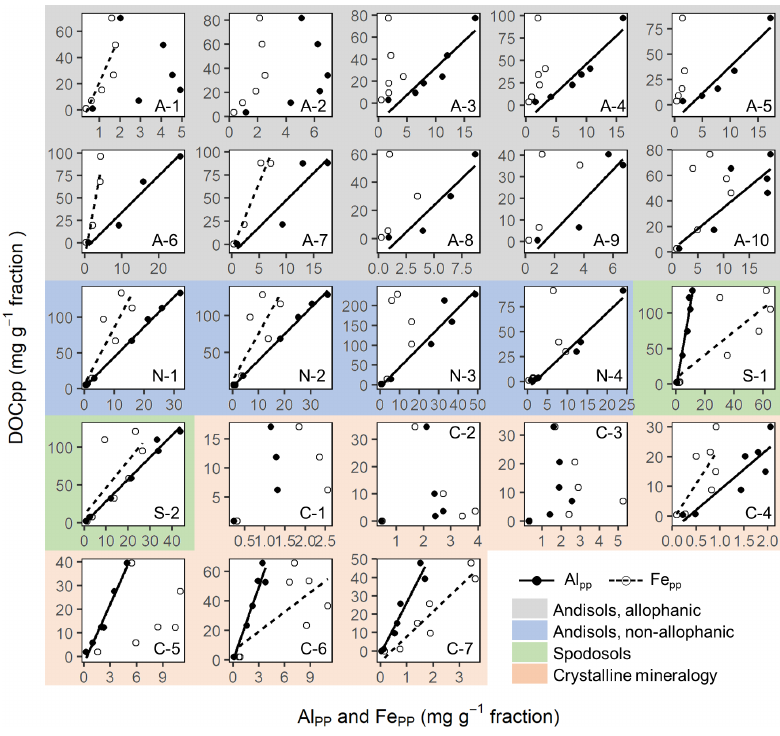
Figure A6. Scattered plots of pyrophosphate-extractable Fe and Al against dissolved organic C concentration for each soil sample. Soil sample ID in each plot corresponds to that from Table 1. Solid lines represent significant linear regressions at p < 0 .